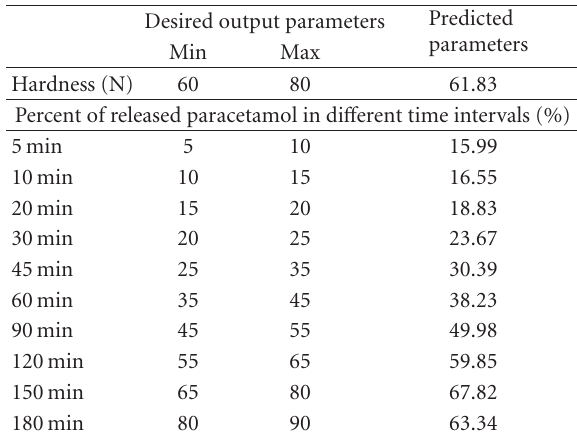
Table 9: The prediction of input parameters based on desired values of